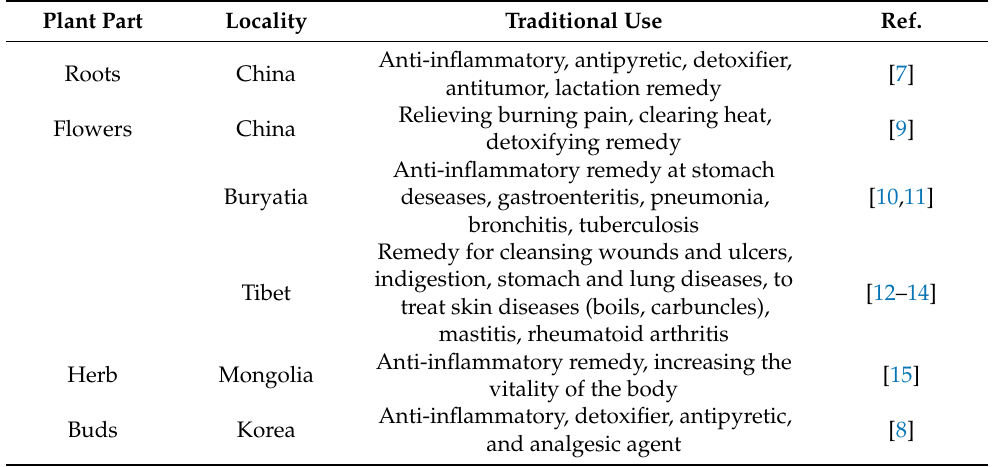
Table 1. Traditional medical uses of R. uniflorum . Plant Part Locality Traditional Use